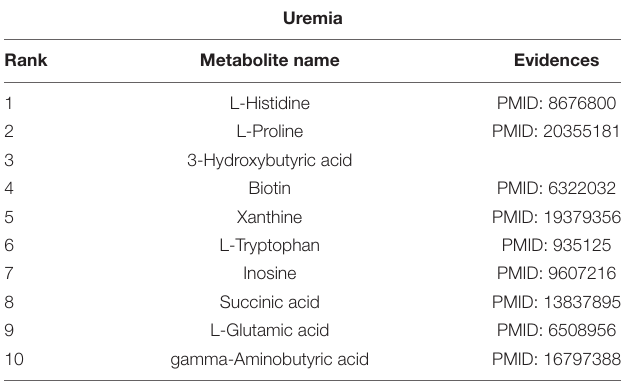
Table 3 | Candidate metabolites of